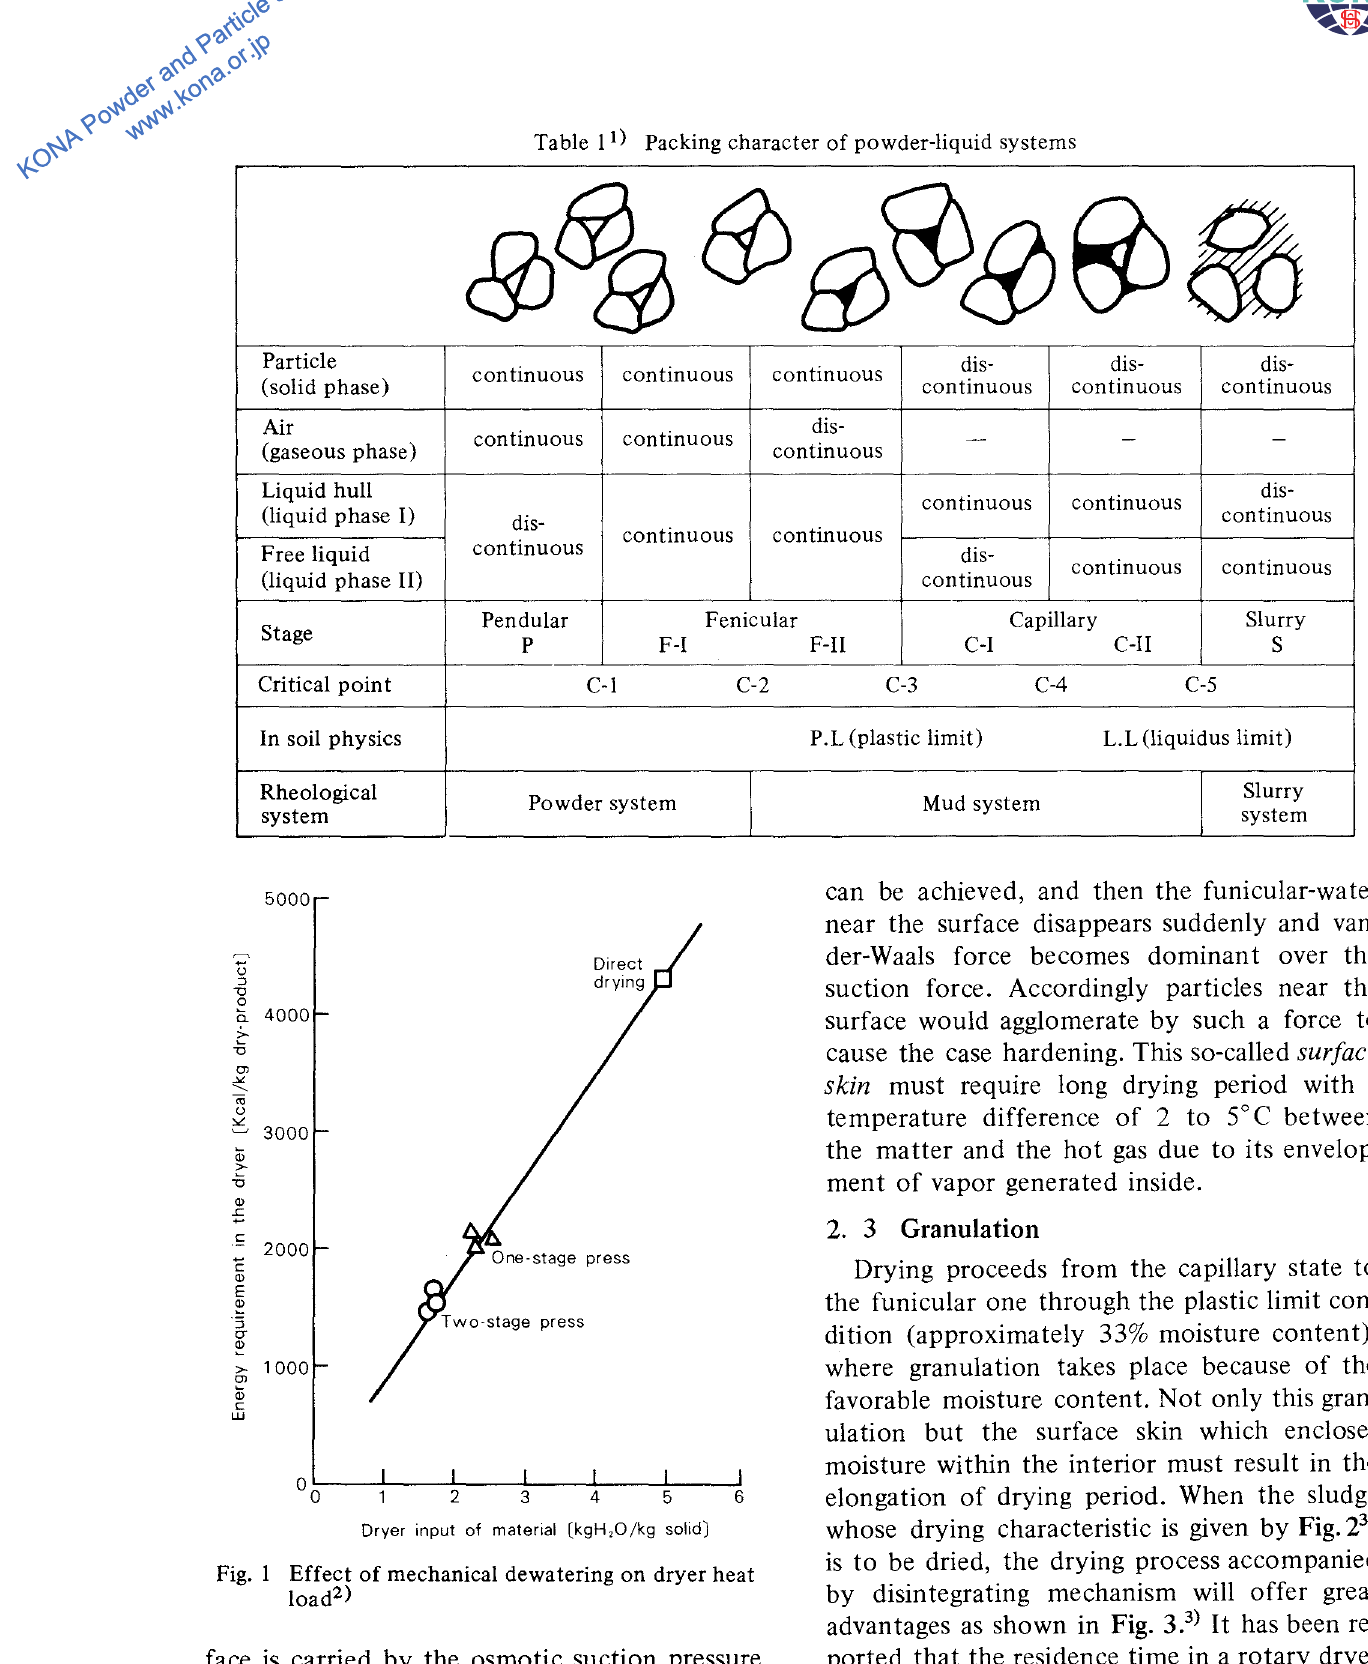
Fig. 1 Effect of mechanical dewatering on dryer heat load